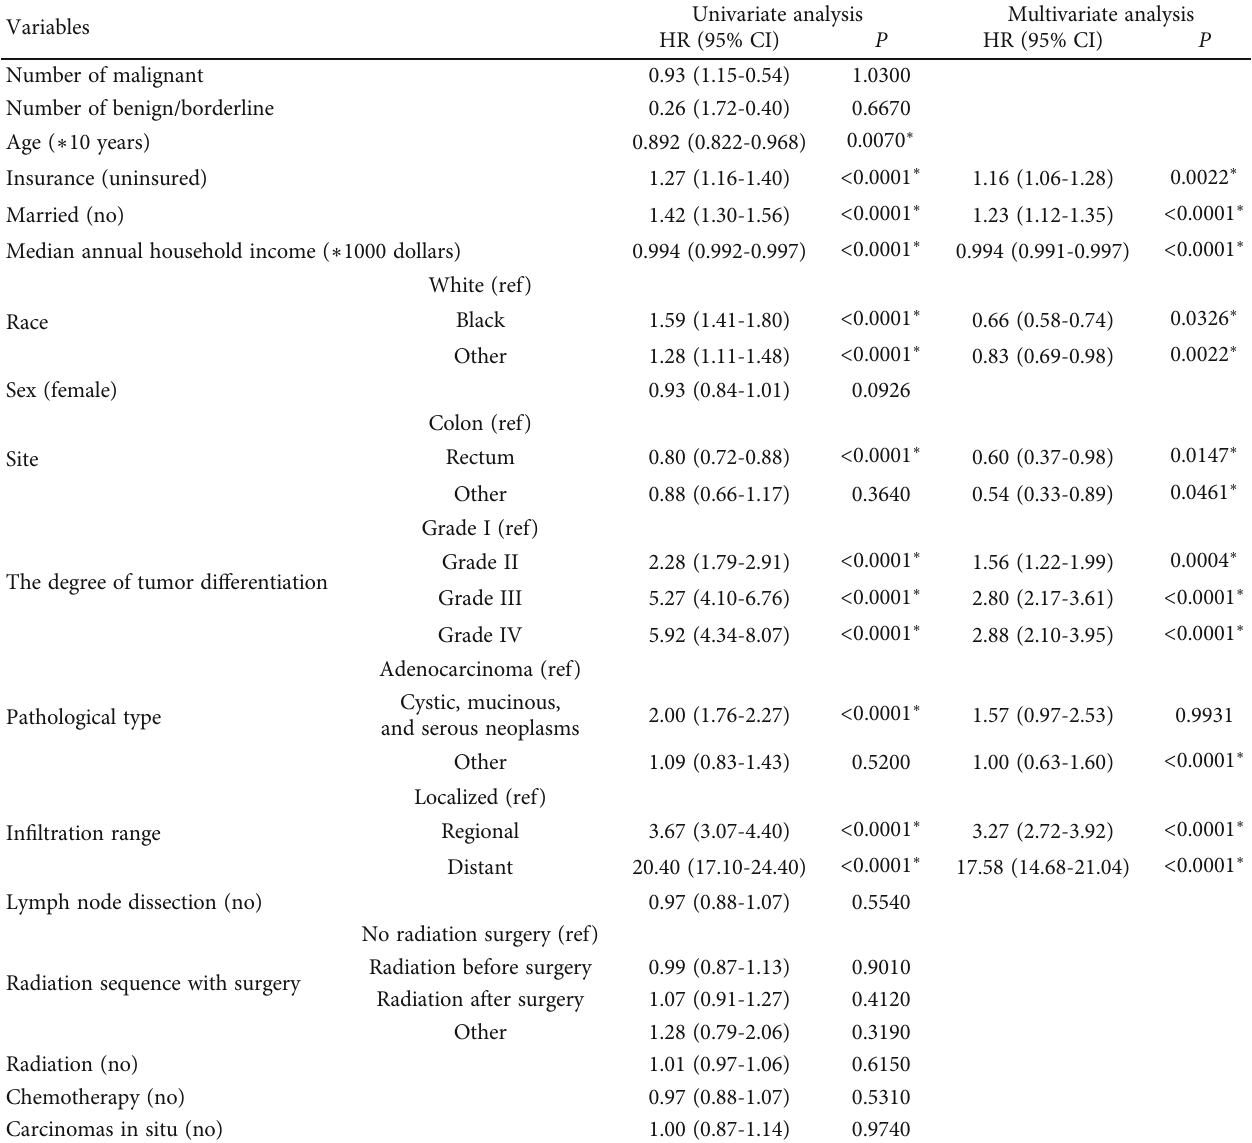
Table 2: Feature ’ s